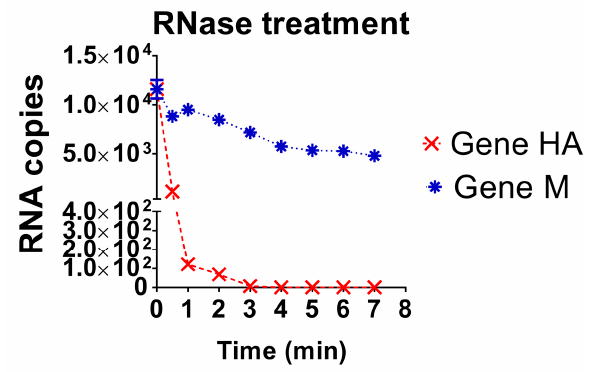
Figure 4. Comparison of the RNA load values under RNase A treatment for HA and M genes. The dynamics of degradation of RNA by the action of RNase A for each gene (HA gene and M gene) is shown. Data is mean of triplicate samples.